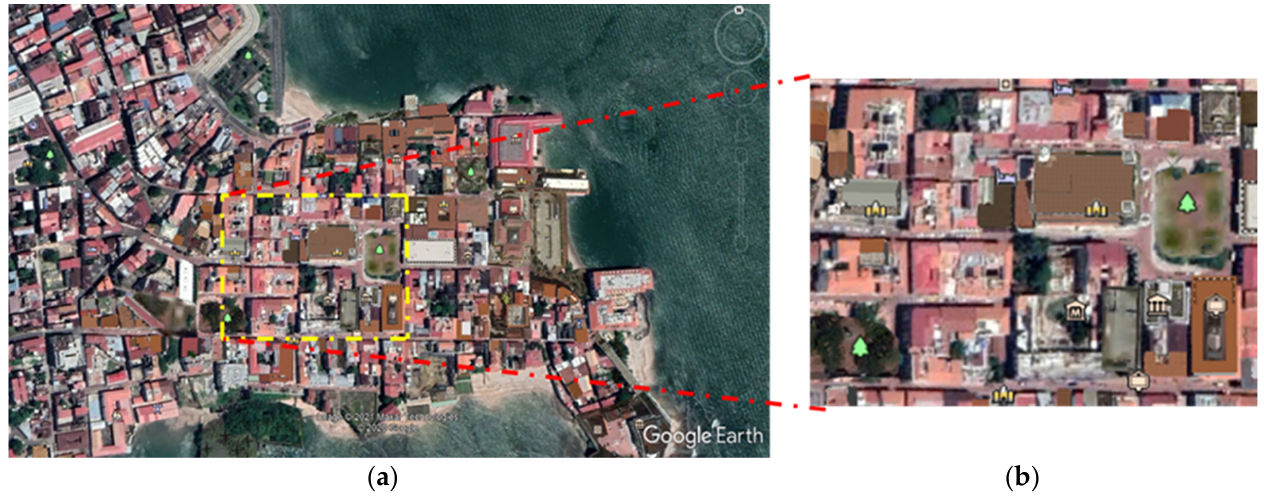
Figure 2. Urban zone under study: ( a ) Satellite view of the Casco Antiguo, and ( b ) cutout view of (290 m × 226 m) [36]. Table 1. Characteristics of materials employed in the 3D model [8].